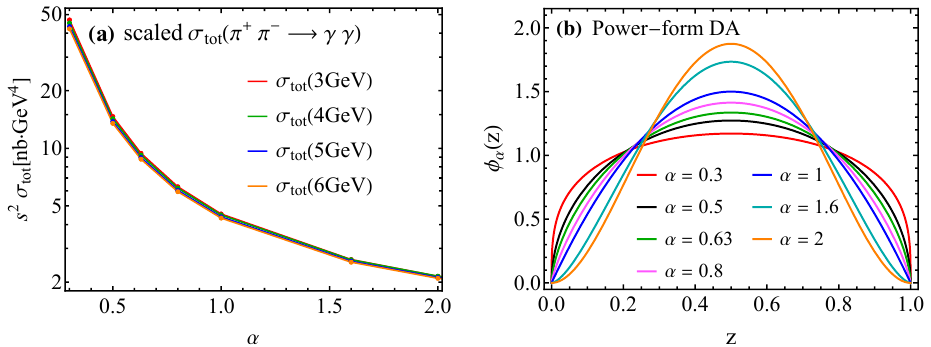
Figure 20. The total cross section (in (a)) for different DAs (shown in (b)) and different CM ener- gies, where a scaling factor s 2 has been multiplied. The total cross section is obtained by integrating √ over q T from 1 GeV to s/ 2 . The dots on the curves are the points that were explicitly